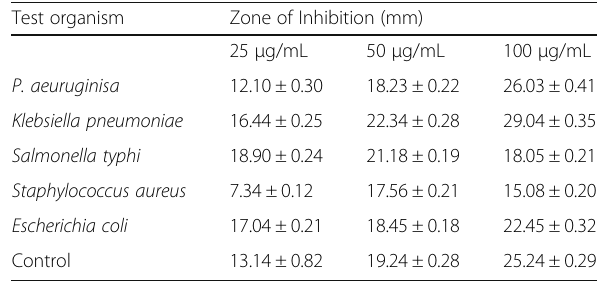
Table 5 Susceptibility of the test organisms to various concentrations of methanol extract of Zingiber